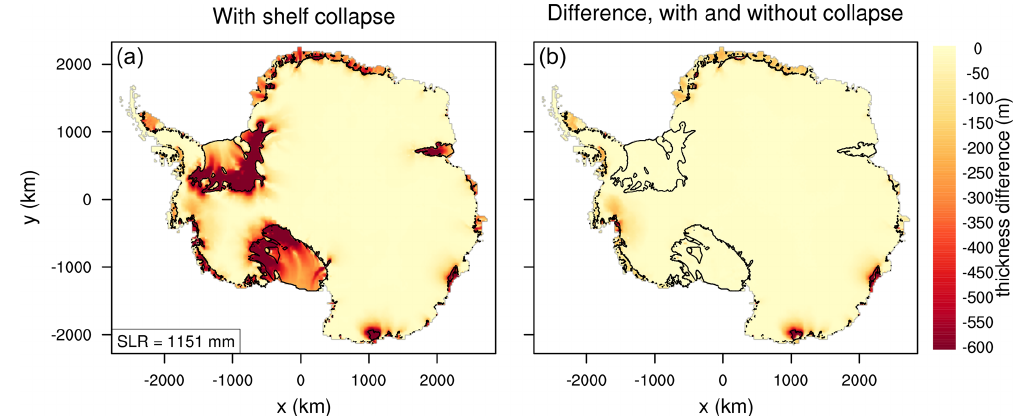
Figure 18. (a) Difference in ice thickness (m) between the years 2500 and 1950 in an experiment with prescribed collapse of small ice shelves. The box in the lower left gives the SLR contribution in this run. (b) Difference in the ice thickness change (m) during 550-year experiments with and without shelf collapse. Both runs use the nonlocal-slope-PIGL melt scheme with CCSM4 ocean forcing. Negative values indicate greater thinning in the run with shelf collapse. Black lines show boundaries of floating ice at the end of the run with shelf